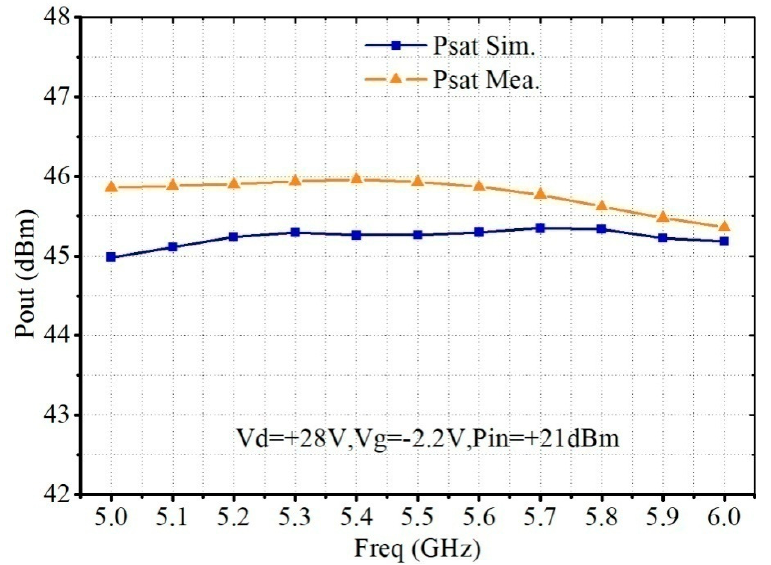
Figure 8. Simulated and measured saturated output power of the proposed C-band 30 W PA MMIC.